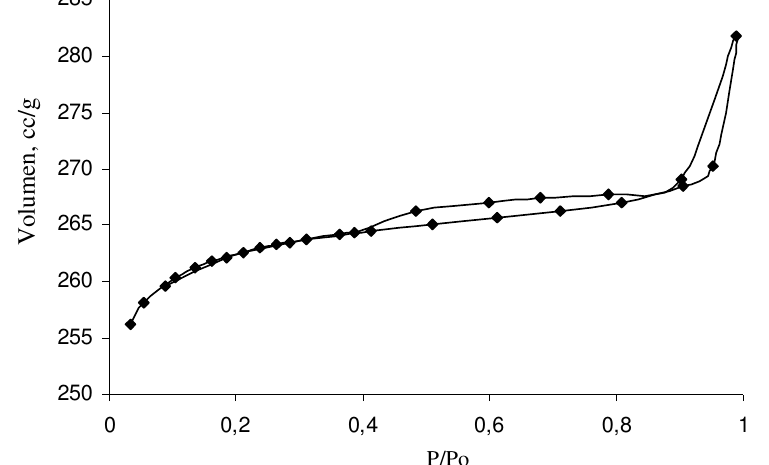
Figure 11. Adsorption isotherm of nitrogen for the sieve obtained from sample